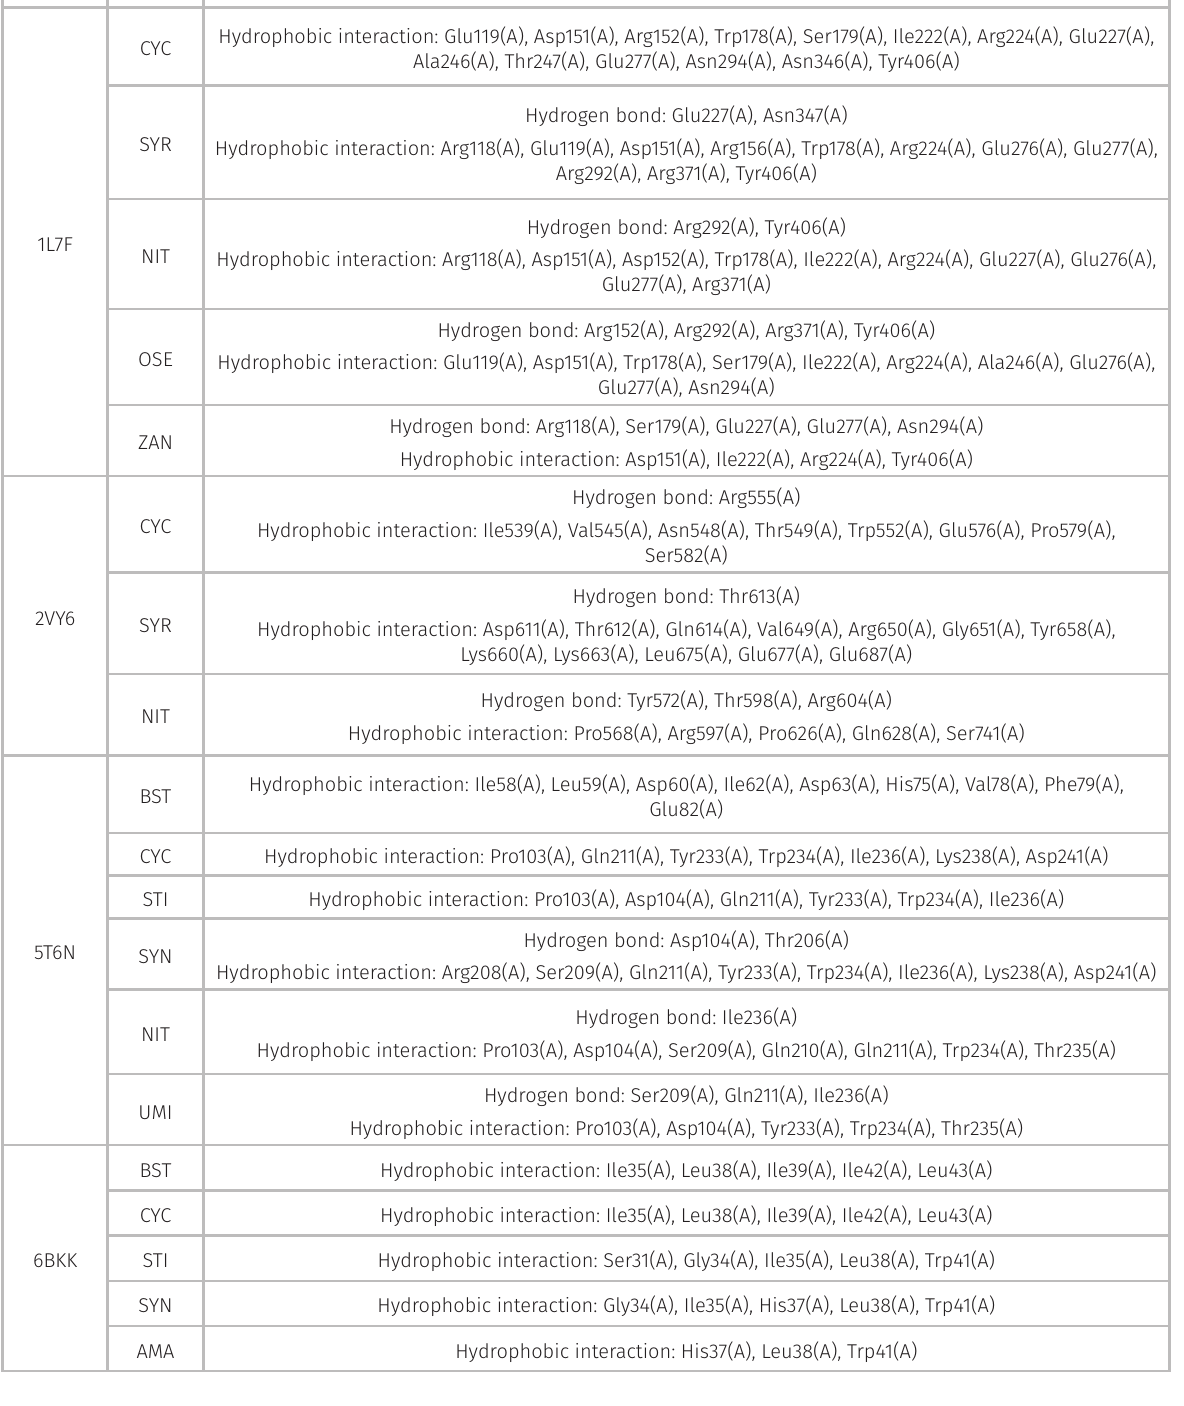
Table III. Interactions between the S. brasiliensis phytocompounds, positive controls and the protein targets. AMA: Amantadine; UMI: Umifenovir; BTS: β-Sitosterol; CYC: Cycloartenone; NIT: Nitazoxanide; OSE: Oseltamivir; STI: Stigmast-4-en-3-one; SYN: Syringaresinol; ZAN: Zanamivir.